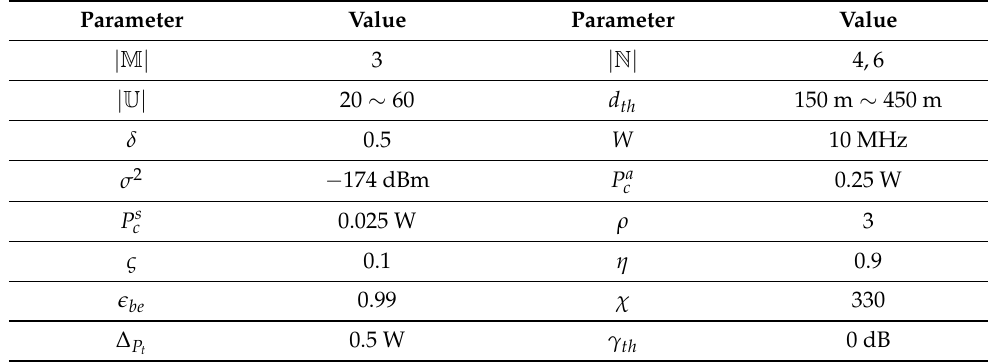
Figure 2. Energy efficiency and reward vs. episode when | U | = 20, | M | = 3, and | N | = 4, and global optimum vs. local optimum in two-agent case. ( a ) Accumulated energy efficiency. ( b ) Accumulated reward. ( c ) Global optimum vs. local optimum. Table 1. Simulation